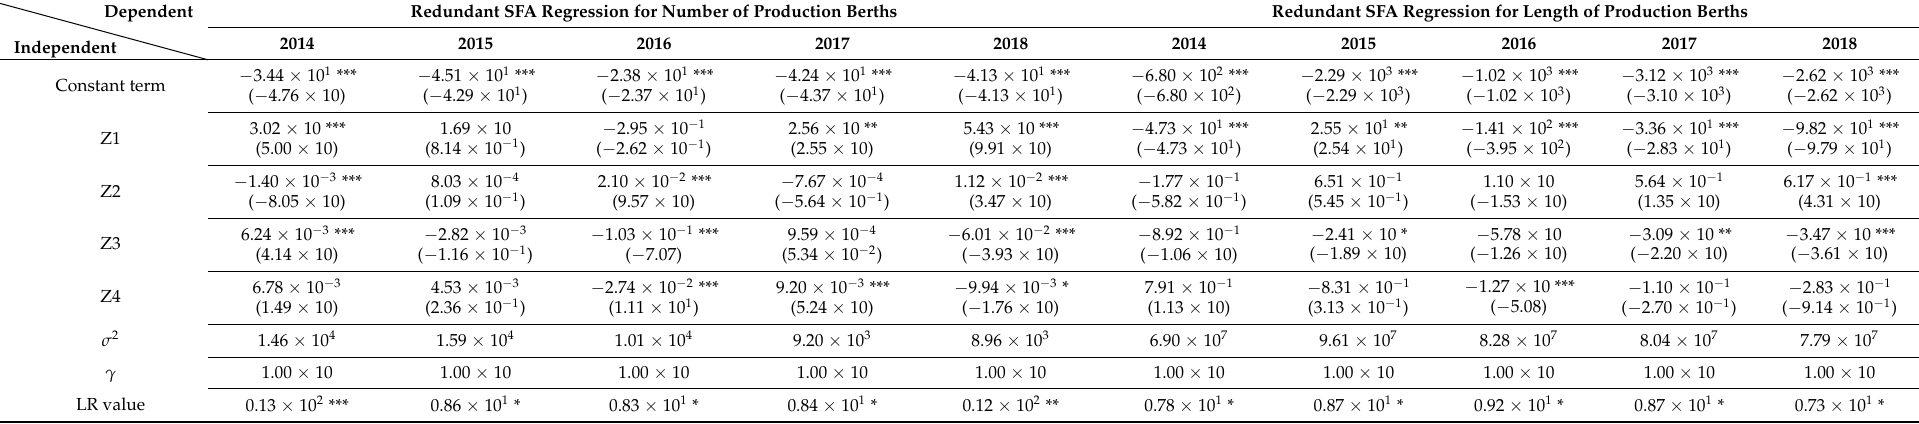
Table 3. The SFA results in stage II